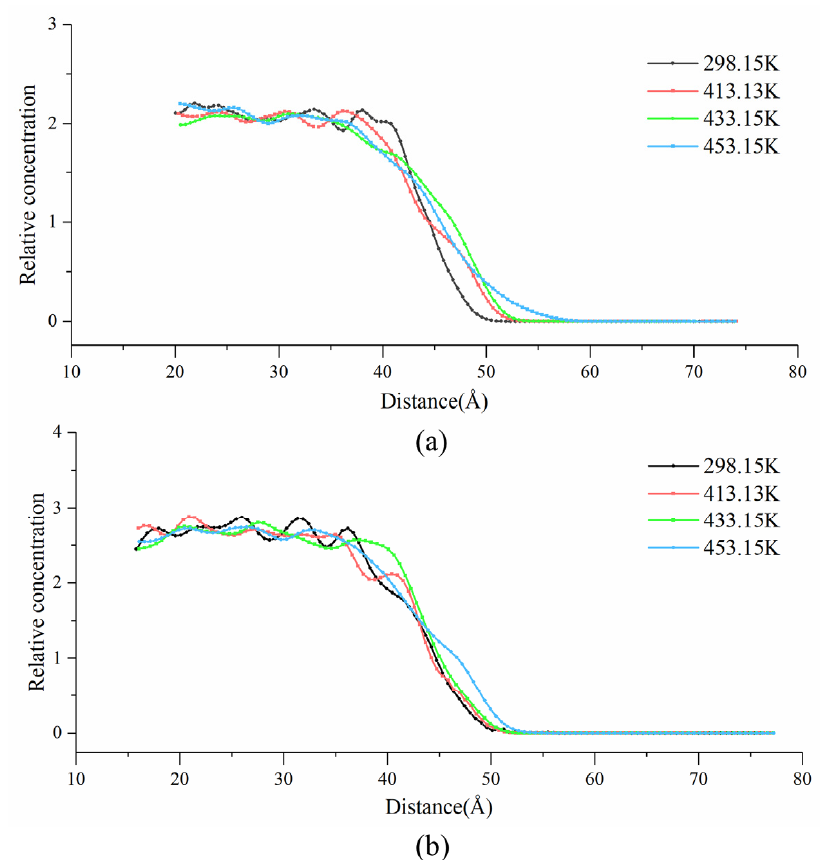
Figure 18. Evolution curves of relative concentration of virgin asphalt with simulation temperature